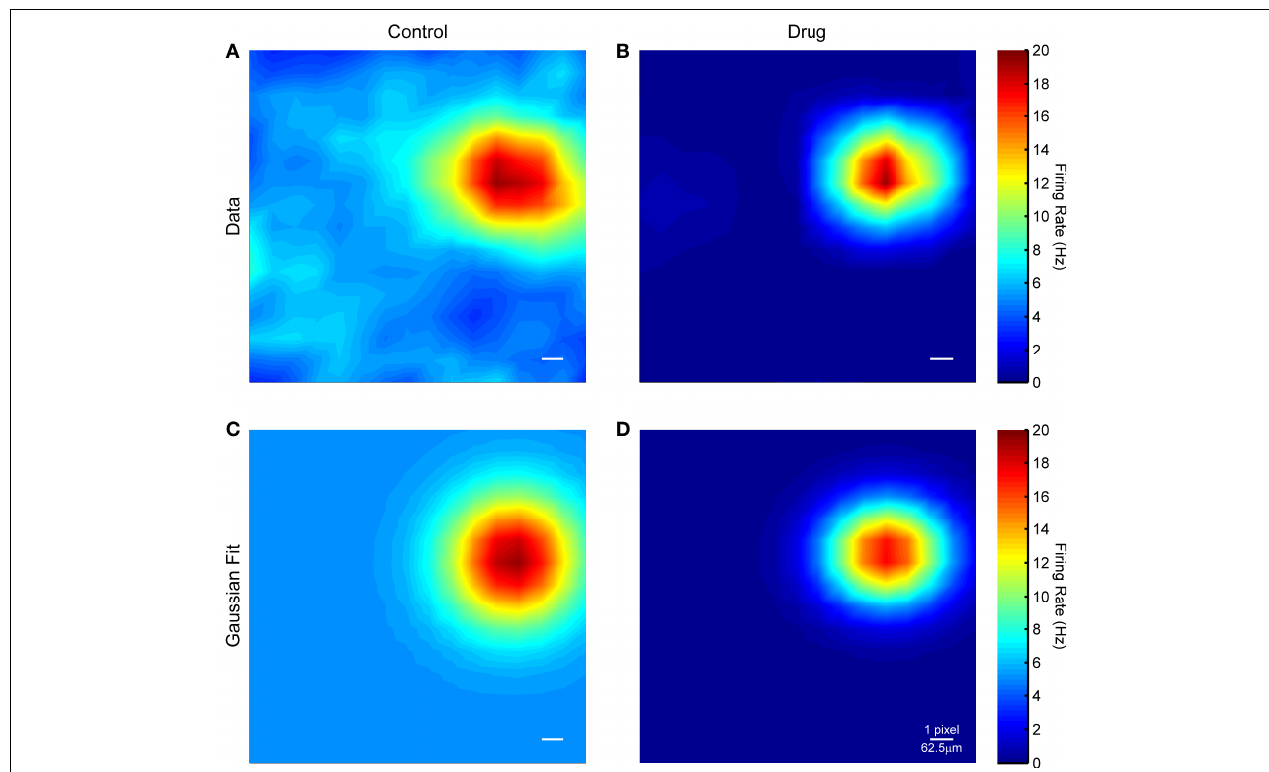
FIGURE 7 | (A) Spike triggered average for an example RGC in control conditions. (B) Spike triggered average for the same cell in the presence of 80 µ M MFA. (C,D) Gaussian fits to the data in (A,B) . The scale bar in each panel is one µ LED array pixel or approximately 62.5 µ m in length.